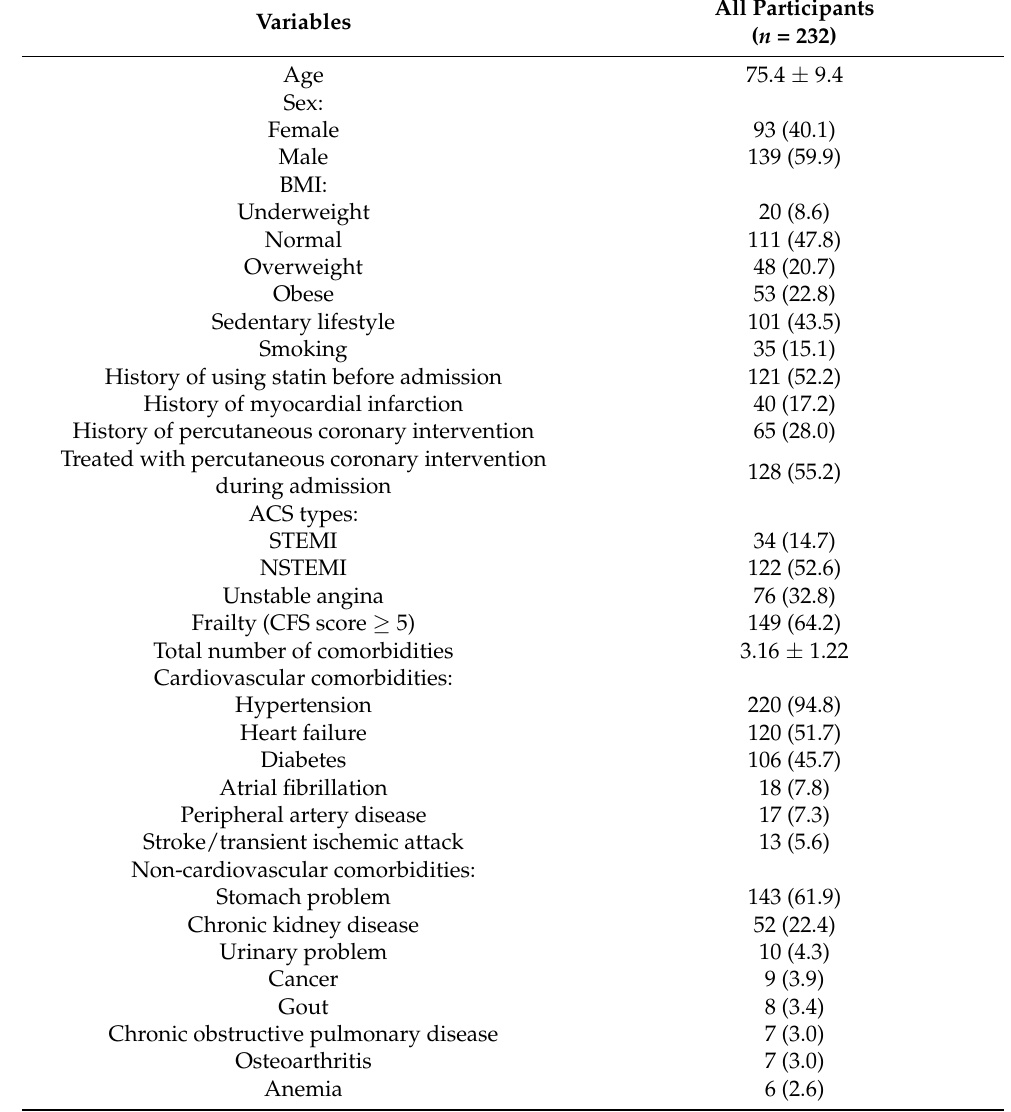
Table 1. Participant